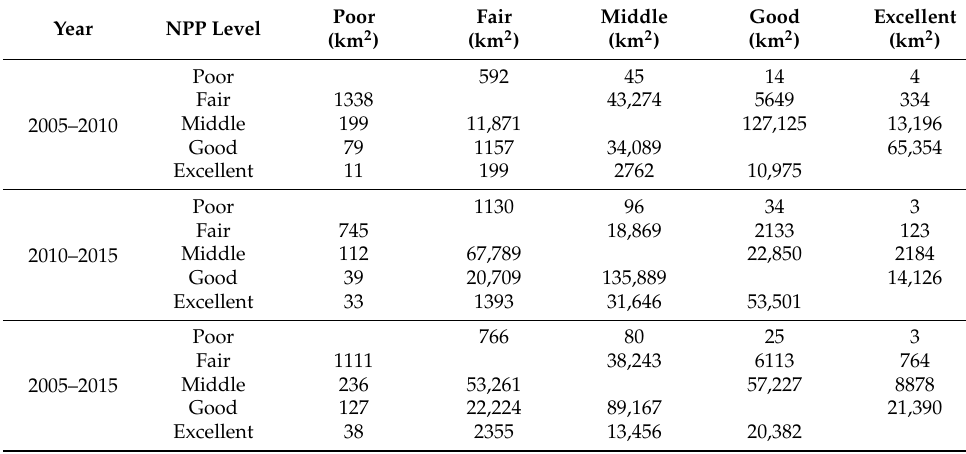
Table 7. Area transfer matrix of different LAI levels in the NFB from 2005 – 2015. Year